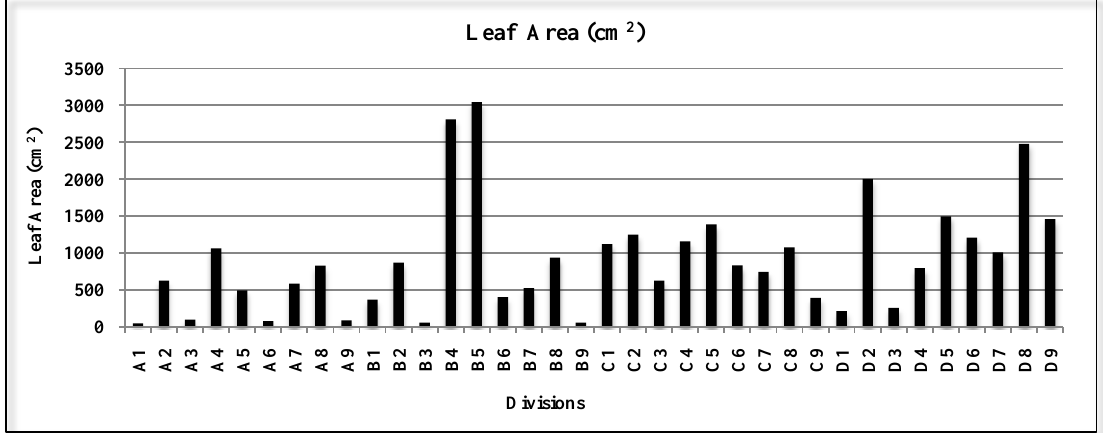
Figure 12. Leaf area of each of the 36 internal divisions of the reference